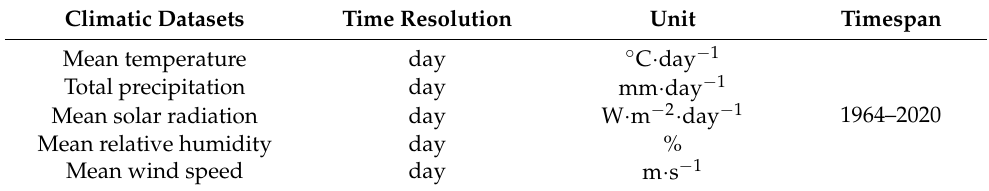
Table 1. Climatic datasets for runoff simulations. Climatic Datasets Time